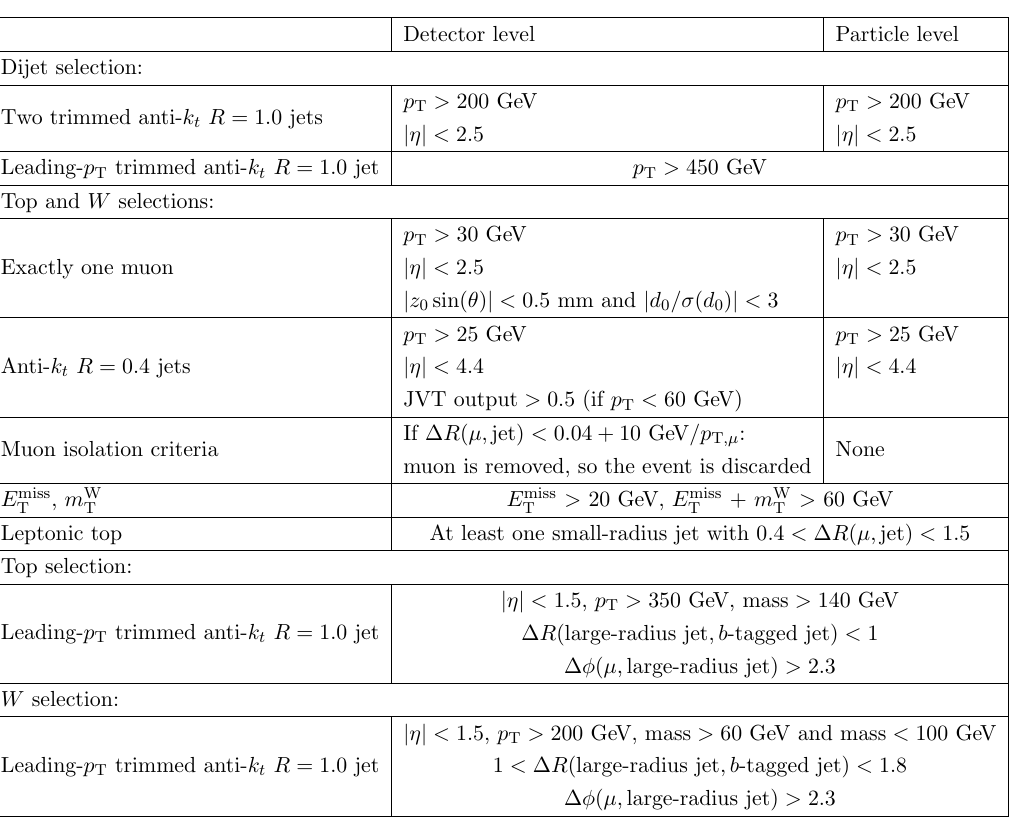
Table 2 . Summary of object event selections for detector-level and particle-level dijet and t (cid:22) t events. \Leptonic top" refers to the top quark that decays into a leptonically decaying W boson, while \ b -tagged jet" refers to small-radius jets that pass a b -tagging requirement. The top and W selections are common up to the requirement on the leptonic top, then they di(cid:11)er on the require- ments on the leading- p T trimmed large-radius jet. All selections are inclusive, unless otherwise